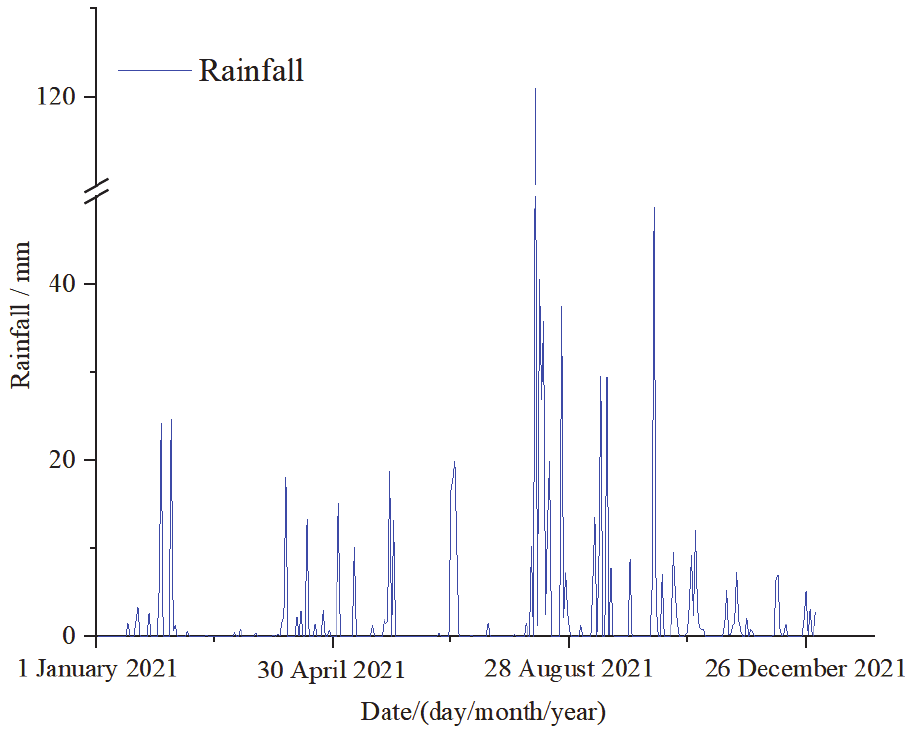
Figure 2. Daily rainfall data of sample plots during 2021.